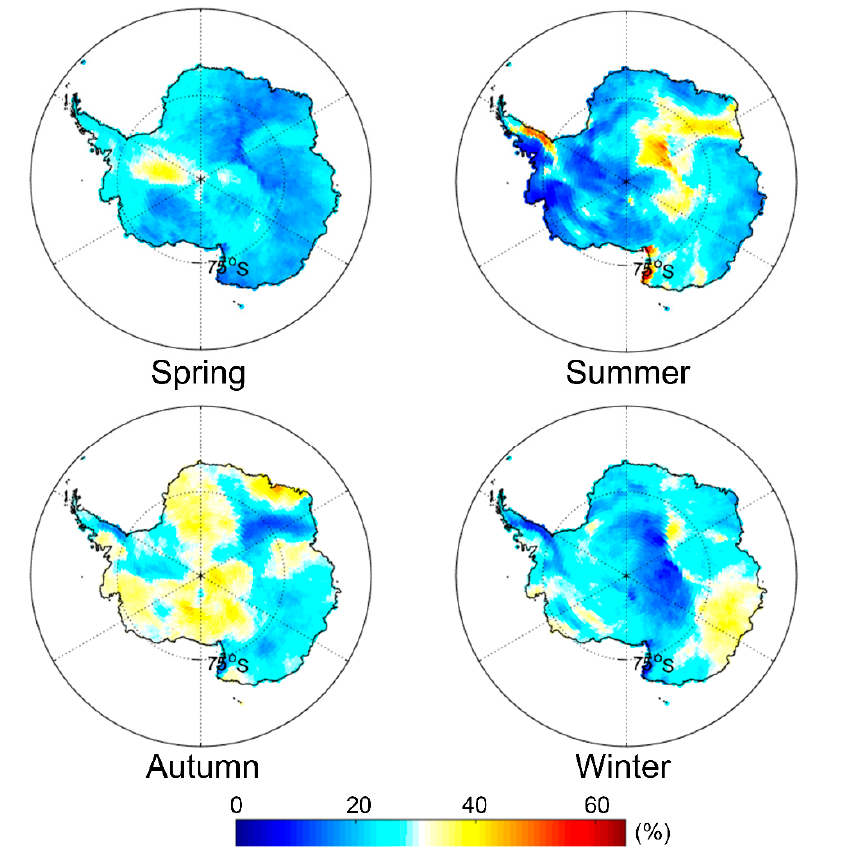
Figure 7. Percentage of EPEs in the four seasons (%) over the AIS. Different colors indicate the percentage of the EPEs in each grid.